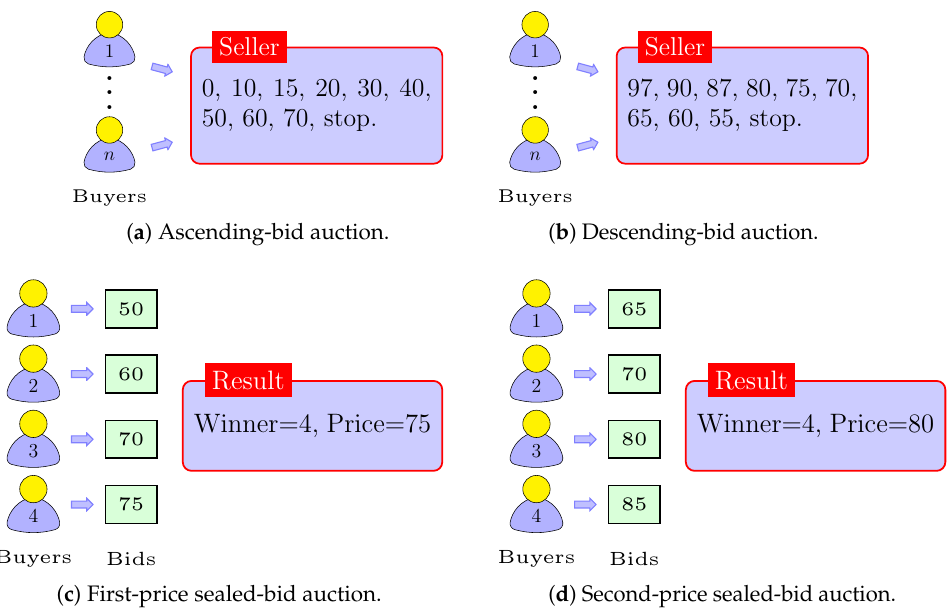
Figure 1. Illustrations of the various types of